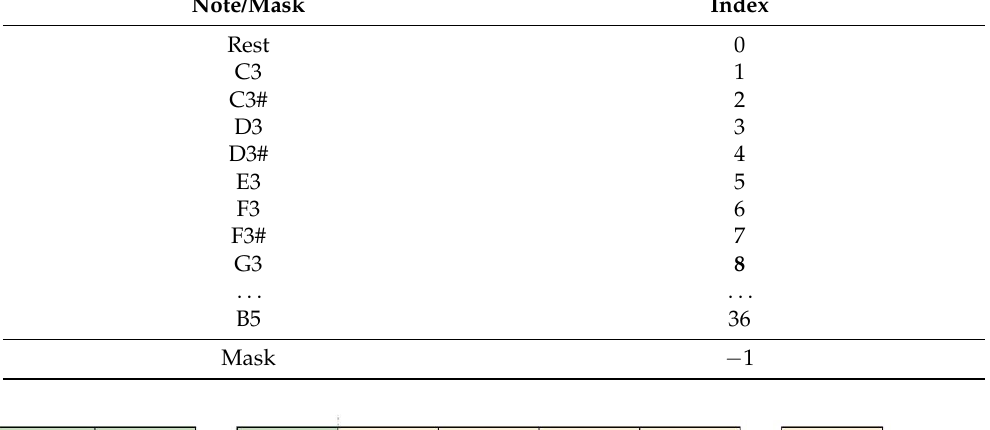
Table 2. Note-index lookup dictionary for the note converter.